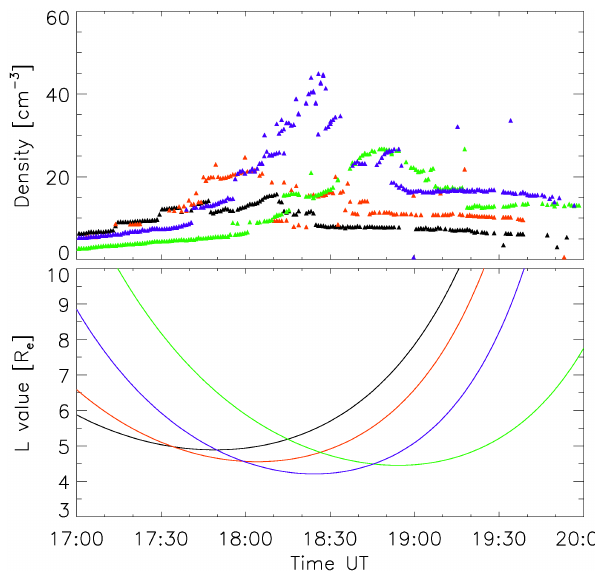
Fig. 10. Electron densities determined from the spectra provided by the WHISPER instrument between 17:00 and 20:00UT on 5 September 2002. The bottom panel shows the L-value for refer- ence. Different spacecraft are again coded by different